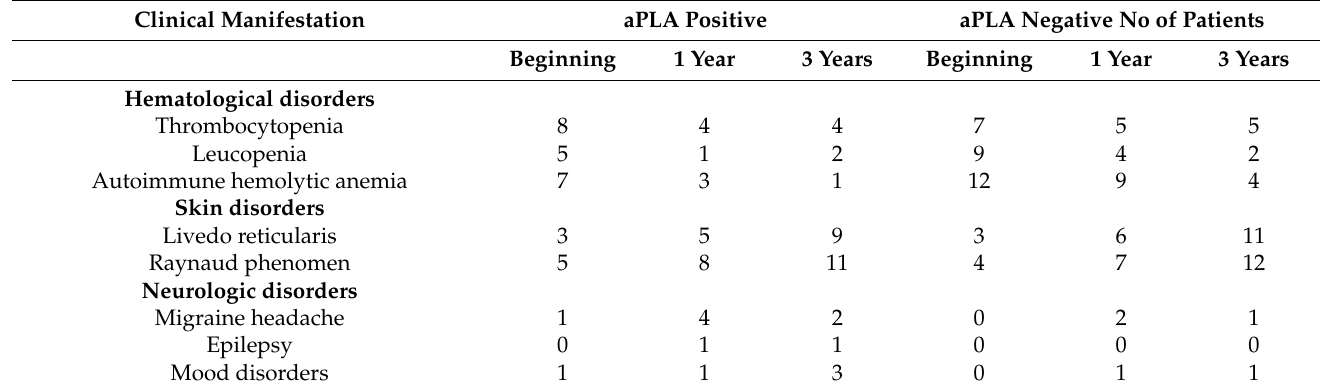
Table 2. Presentation of clinical manifestations in the group of aPLA positive and aPLA negative